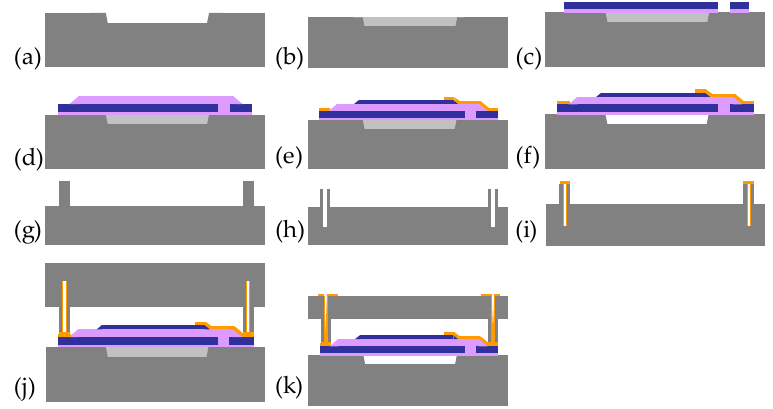
Figure 6. Base wafer flow: ( a ) Silicon etching; ( b ) SiO 2 deposition and chemical mechanical planarization (CMP); ( c ) BE deposition and pattern; ( d ) AlN/TE deposition and pattern; ( e ) Au deposition and pattern; ( f ) sacrificial layer release; Cap wafer flow: ( g ) trench etch and pattern; ( h ) vias etch ( i ) 0.2 µ m Cr/1 µ m Au deposition and pattern; Bonding part: ( j ) Au-Au bonding; ( k ) CMP, electroplate, and Au